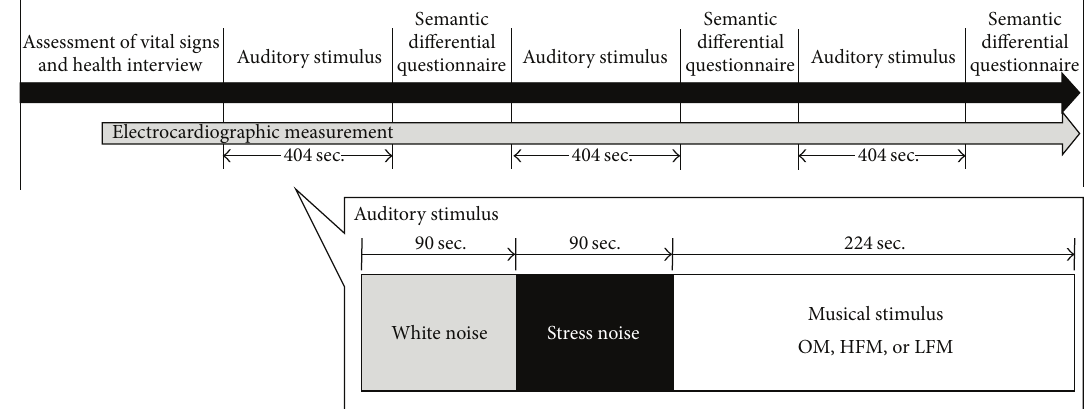
Figure 1: Experimental procedure. One of three musical stimuli (OM, HFM, and LFM) was selected in a counterbalanced random order. The participants were asked to complete the semantic differential questionnaire after listening to each piece of music. HFM: music with an amplified high-frequency component; LFM: music with an amplified low-frequency component; OM: original